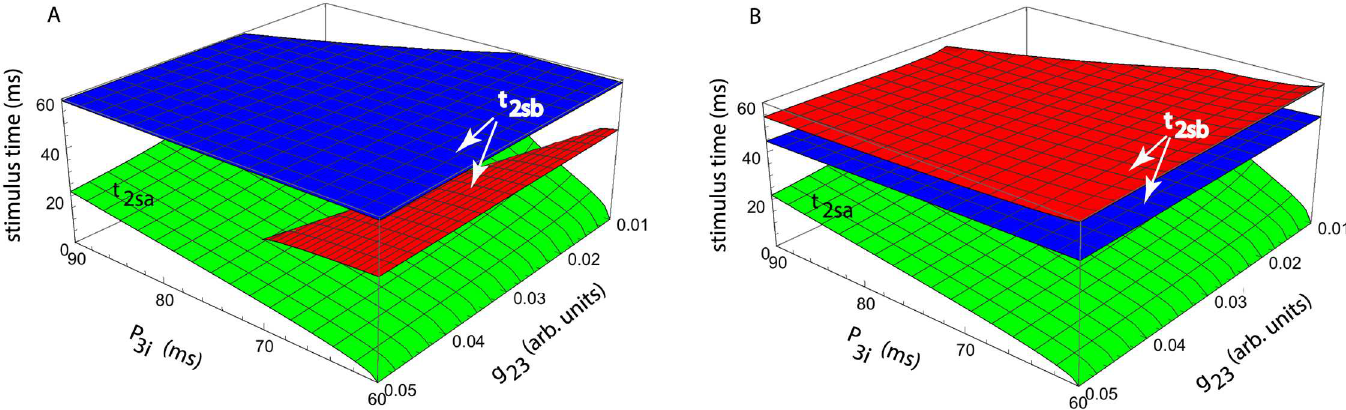
Fig 5. Phase-locked solutions t (cid:3) and t (cid:3) (vertical axes) versus the intrinsic period of the interneuron P 3 i and the coupling strength g 23 . ( A ) The first 2 sa 2 sb stimulus time t (cid:3) only dependson P 3 i / P 1 i and g 23 —see green surface. For a fixed intrinsicperiodratio P 2 i / P 1 i = 70/60, the second stimulus time t (cid:3) 2 sa also on the couplingstrength g 12 = 0.012 (red surface) and g 12 = 0.05 (blue surface). ( B ) For a fixed coupling g 12 = 0.015, the second stimulus time t (cid:3) dependence on the intrinsicfiring periods P 2 i / P 1 i = 60/60 (red surface) and P 2 i / P 1 i = 70/60 (blue surface) shows that the solution space is wider for shorter intrinsicperiods.